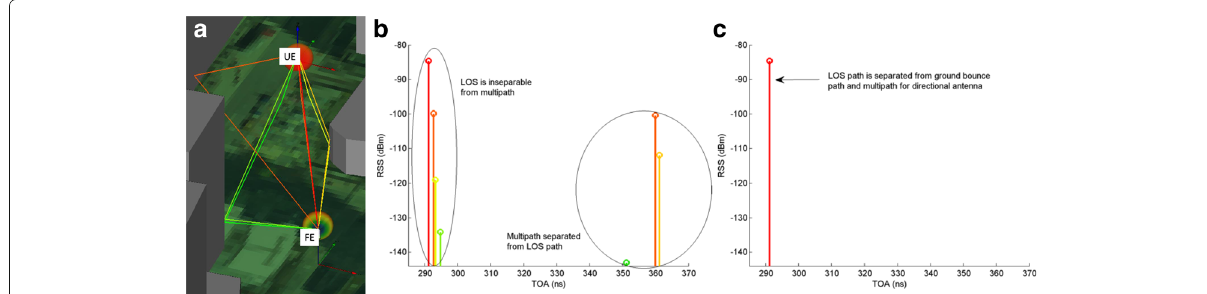
Fig. 3 a Geometry and ray tracing paths for Wireless Insite simulation in an urban environment. Paths are colored based on RSS where the strongest RSS path is red and the weakest RSS paths is green. b TOA of simulation with 80° 3 dB beamwidth. c TOA of simulation with 28 ◦ 3 dB